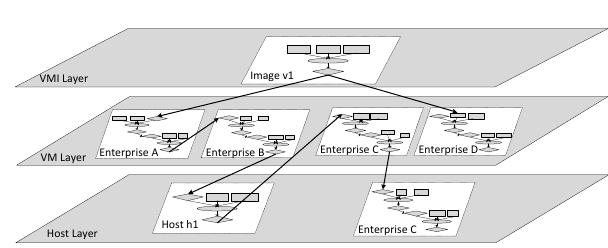
Figure 3. Features of the Public Cloud Structure